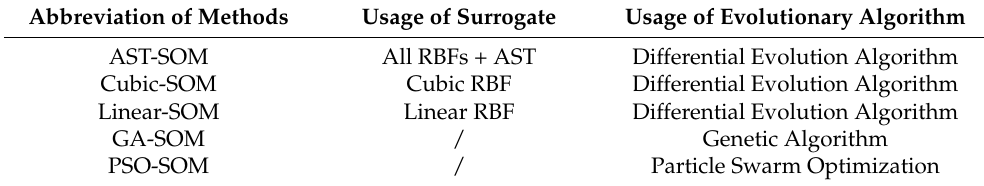
Table 1. The basic information of all compared